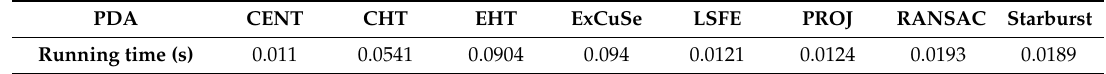
Table 4. Running time of all tested algorithms.